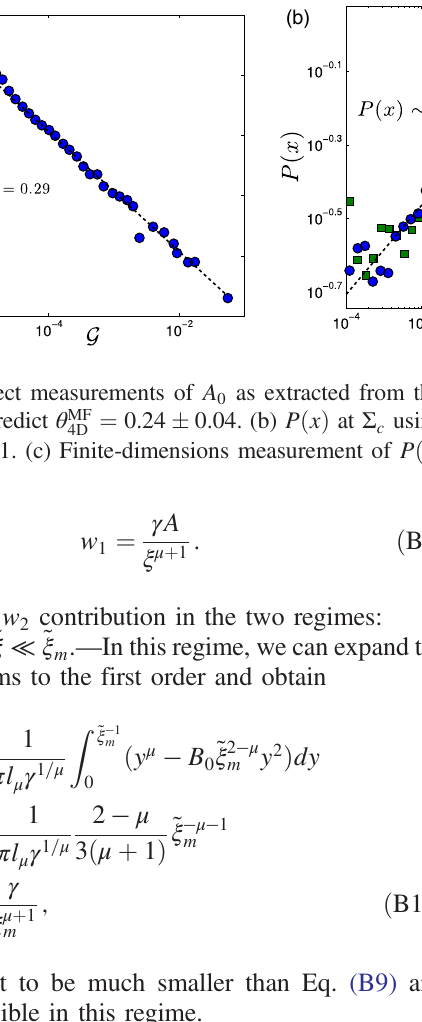
¼ 0 . 25 (cid:3) 0 . 01 , D